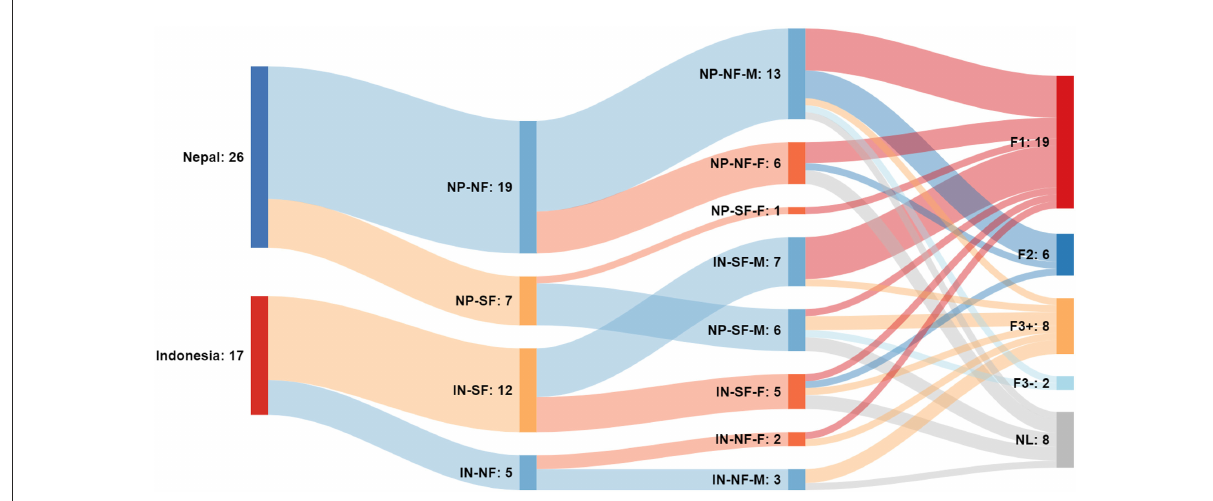
FIGURE4 Cumulative distribution of respondents of SF-NF segment across factors (F1, F2, F3 Acronyms: Nepal (NP), Indonesia (IN), female (F), male (M), non-loaded respondents (NL).